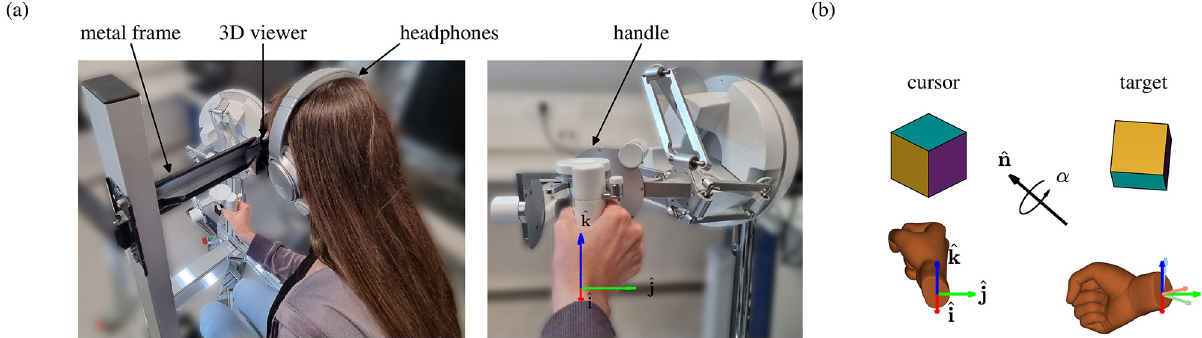
Fig 1. Experimental setup and orientation-matching task. (a) Participants were seated in front of a robotic manipulator and interacted with it using their right hand. We projected the VE onto the three-dimensional viewer that was mounted on a metal frame and directed at 45˚ towards the robotic manipulator. To avoid external interruptions, participants wore noise cancelling headphones. (b) Participants controlled the orientation of a cursor cube that was positioned at the center of the VE by rotating their right hand. They were instructed to match the orientation of the cursor cube to that of a target cube, which was rotated α around ^ n with respect to the initial cursor orientation. Examples of initial cursor orientation (left) and target orientation (right) are illustrated, along with the orientation of the participant’s right hand. The dark red, green and blue arrows depict an extrinsic reference frame, and the light arrows depict an intrinsic reference frame (the frames are aligned when the hand is oriented q orientation shown here).